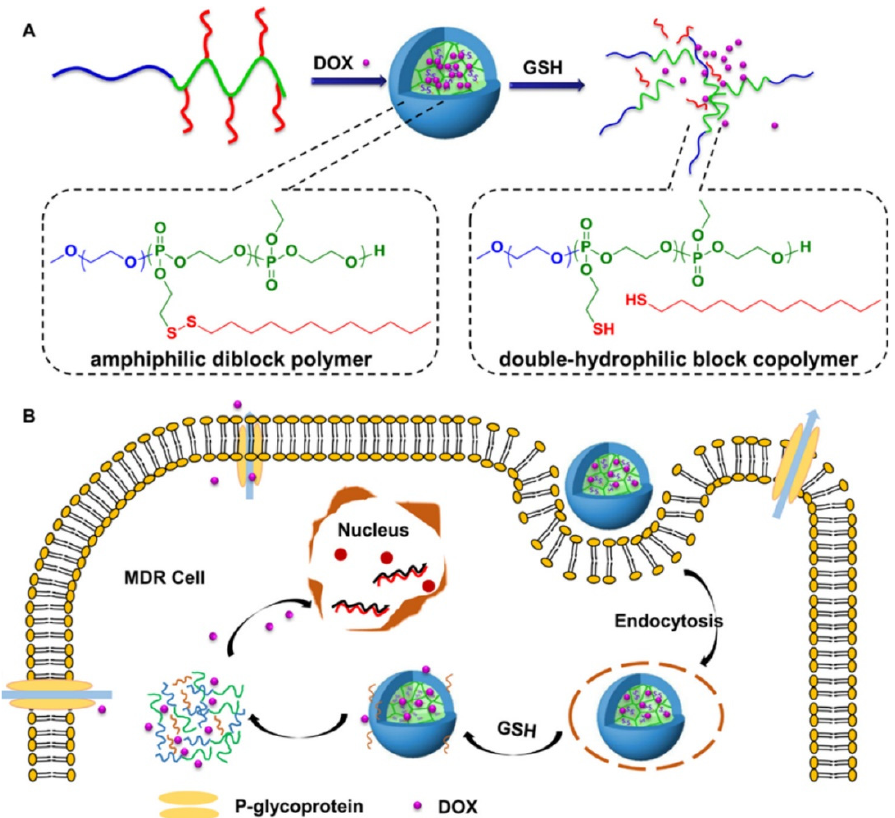
Figure 5. Schematic diagram showing the generation of redox-sensitive micelles made up of polyphosphoesters (PPEs): ( A ) mPEG 45 - b -P(DssEEP 12 - co -EEP 6 ) and mPEG 45 - b -P(DssEEP 15 - co -EEP 20 ). Note: N2-(2-(dodecyldisulfanyl)ethoxy)-1,3,2-dioxaphospholane 2-oxide (DssEEP). ( B ) Methoxy polyethylene glycol (mPEG) loaded with doxorubicin (DOX) is released in the presence of a GSH-rich milieu in the tumor microenvironment. Multidrug resistance (MDR), glutathione (GSH). Reproduced from [64] with permission from the American Chemical Society. Copyright © 2022, American Chemical Society.